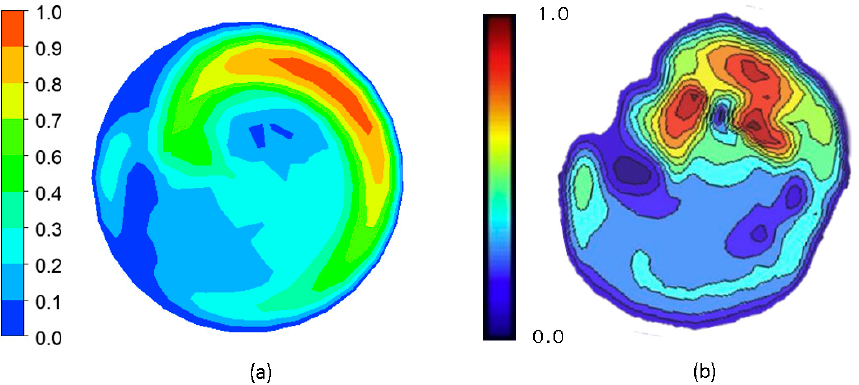
Figure 12. Qualitative validation of the simulation results by comparison of secondary velocity contours on the cross-section of the artery 5 mm from the distal anastomosis toe of a 60° ridged graft. ( a ) CFD result; ( b ) Doppler imaging result from Kokkalis et al. [50].